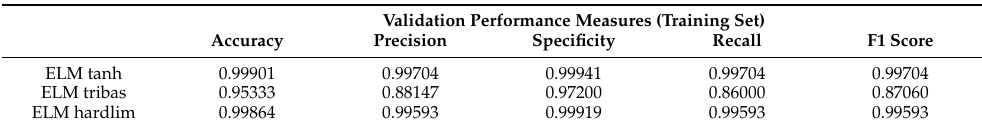
Table 9. Validation (train) classification performance measures of the ELM classifier for three different transfer functions of the ELM algorithm in dataset #1.